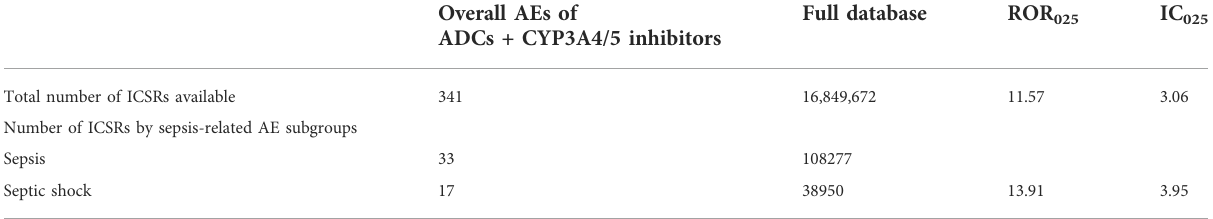
TABLE 8 Sepsis safety signals for ADCs and CYP3A4/5 strong inhibitors combination therapy.